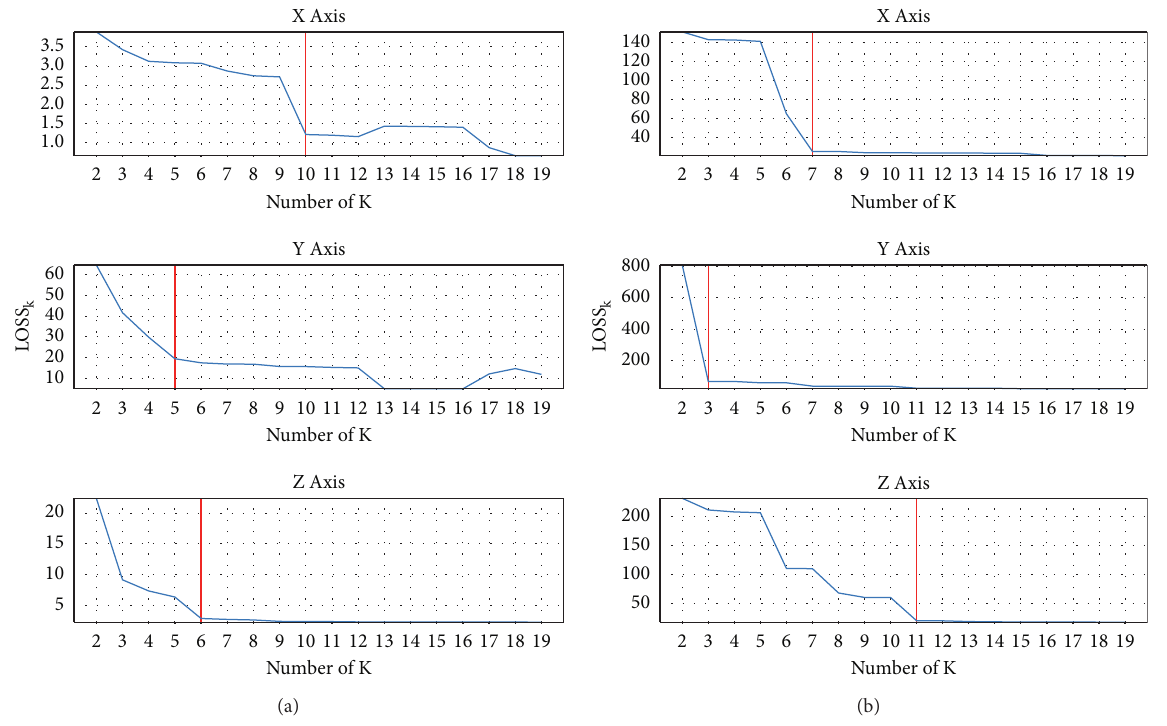
Figure 8: Typical plot of Loss k versus the number of k : (a) monitoring point 2 at +10m; (b) monitoring point 5 at